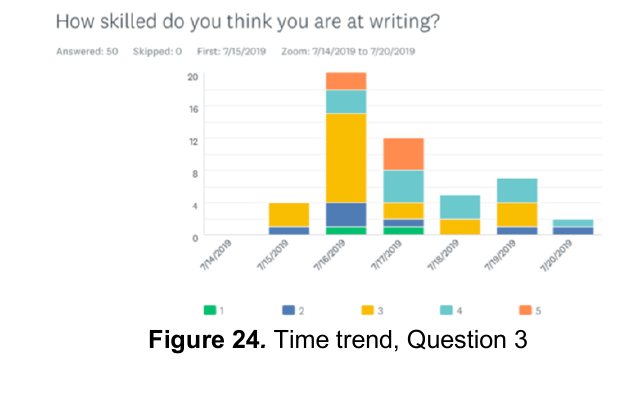
Figure 24 . Time trend, Question 3